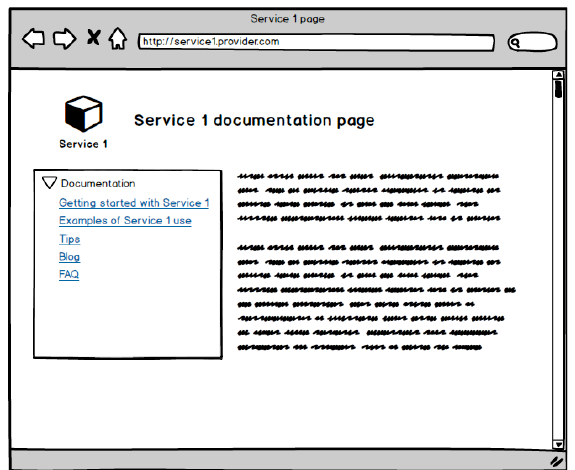
Fig. 8. Service-specific external documentation.